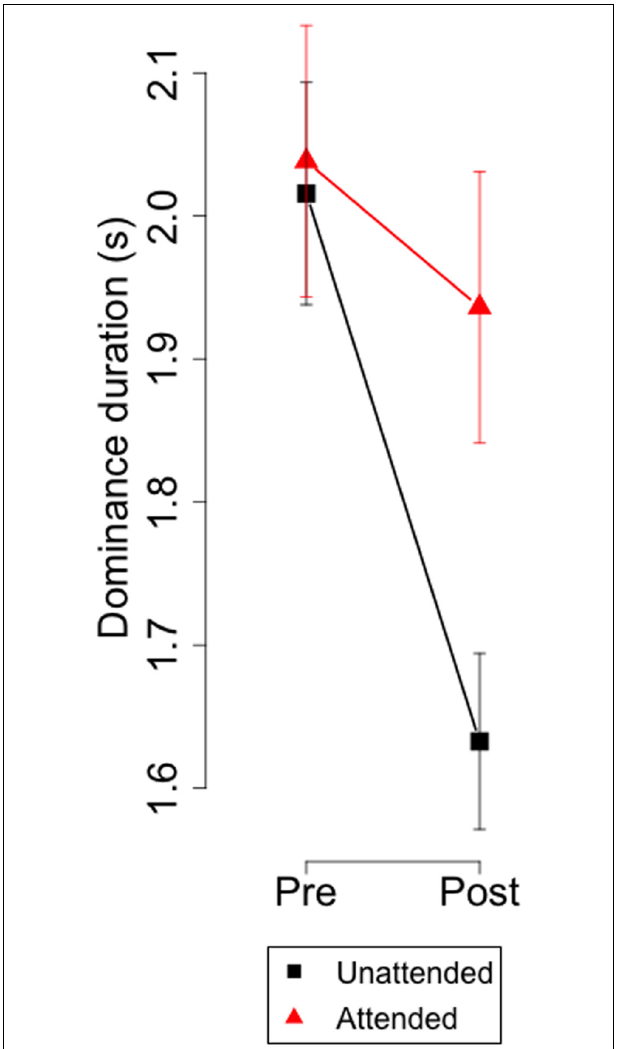
FIGURE 9 | Experiment 3. Group means and 95% confidence intervals of dominance durations for attended and unattended channel before and after the monocular attentional